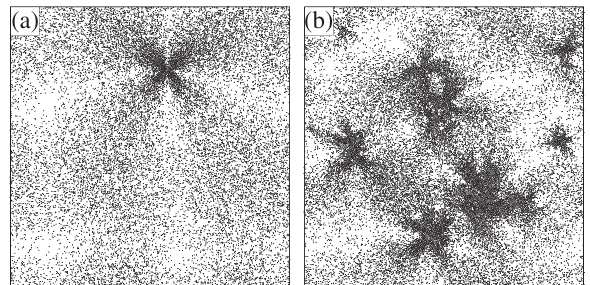
− r FIRE FIG. 5. Displacement fields, r CG , between pairs of i i minima obtained via conjugate gradient ( f r CG g ) and FIRE i algorithms ( f r FIRE g ), following a quench from the same initial i configuration at T ¼ 0 . 07 (a) and T ¼ 0 . 15 (b), for 2D soft spheres with N ¼ 64000 . Arrows magnified by a factor 40 and 2 for (a) and (b),